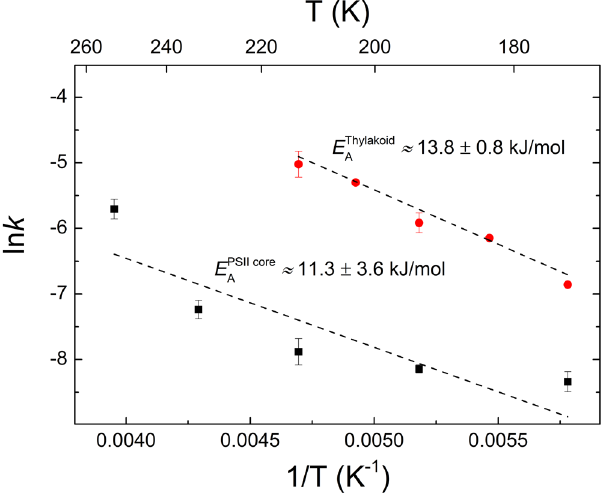
Figure 2. Activation energies associated with the fluorescence relaxation in thylakoid membranes and PSII core particles. The activation energies ( E A ) were calculated from the decay of F m in a temperature range where the decay of F 1 was